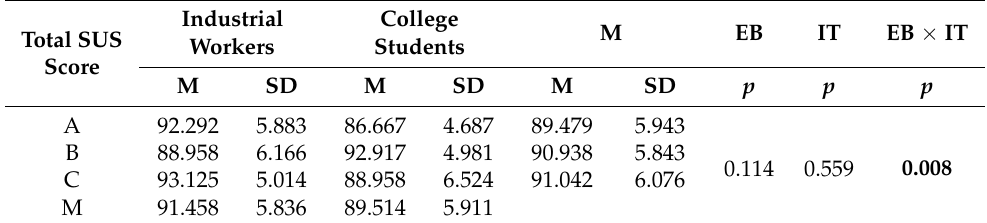
Table 2. Descriptive statistics and two-way ANOVA on the total System Usability Scale (SUS) score. Total SUS